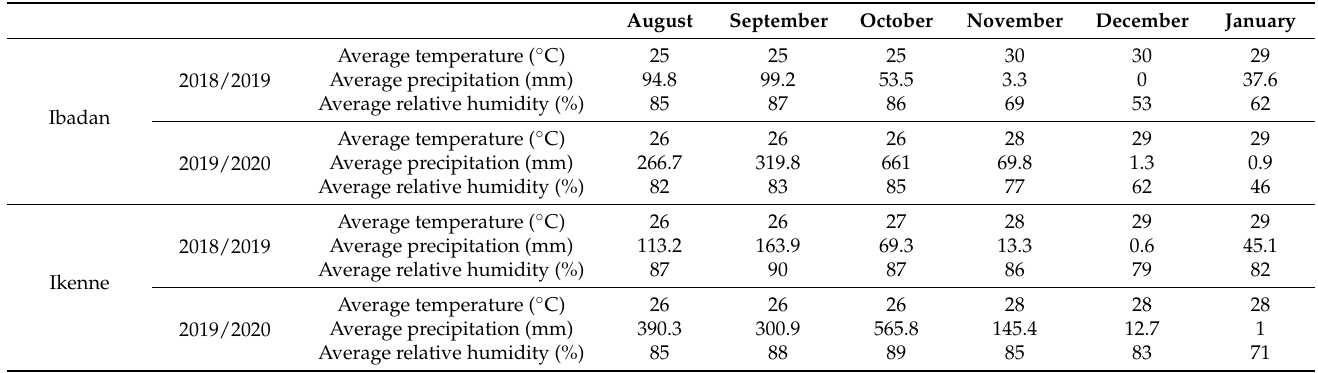
Table 1. Monthly mean meteorological data of the experimental sites during BGN growing season (average of 2018–2019 and 2019–2020 crop